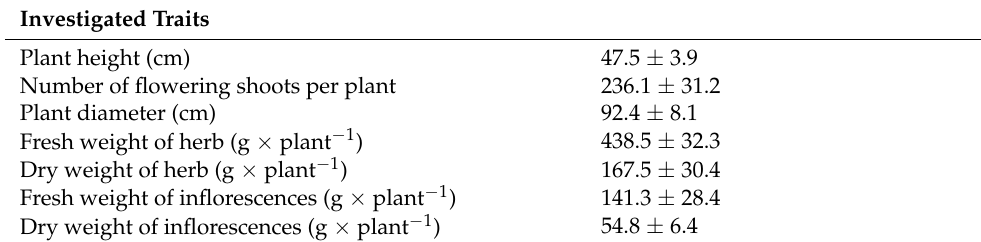
Table 1. Morphological traits and the mass of the plants. Investigated